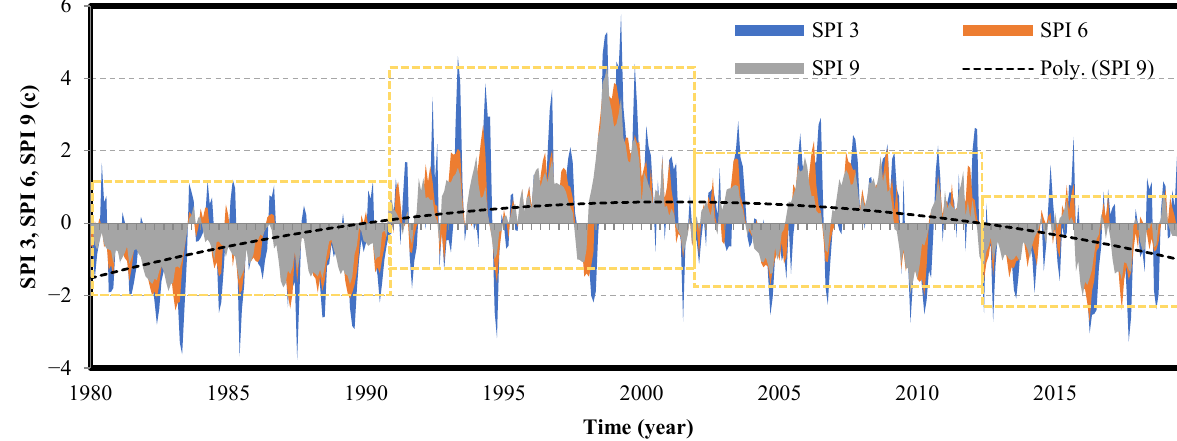
Figure 4. SPI 3 ( a ), SPI 6 ( b ), and SP 9 ( c ) values between 1980 and 2019. During period 1: according to the SPI 3-month drought pattern, there was a